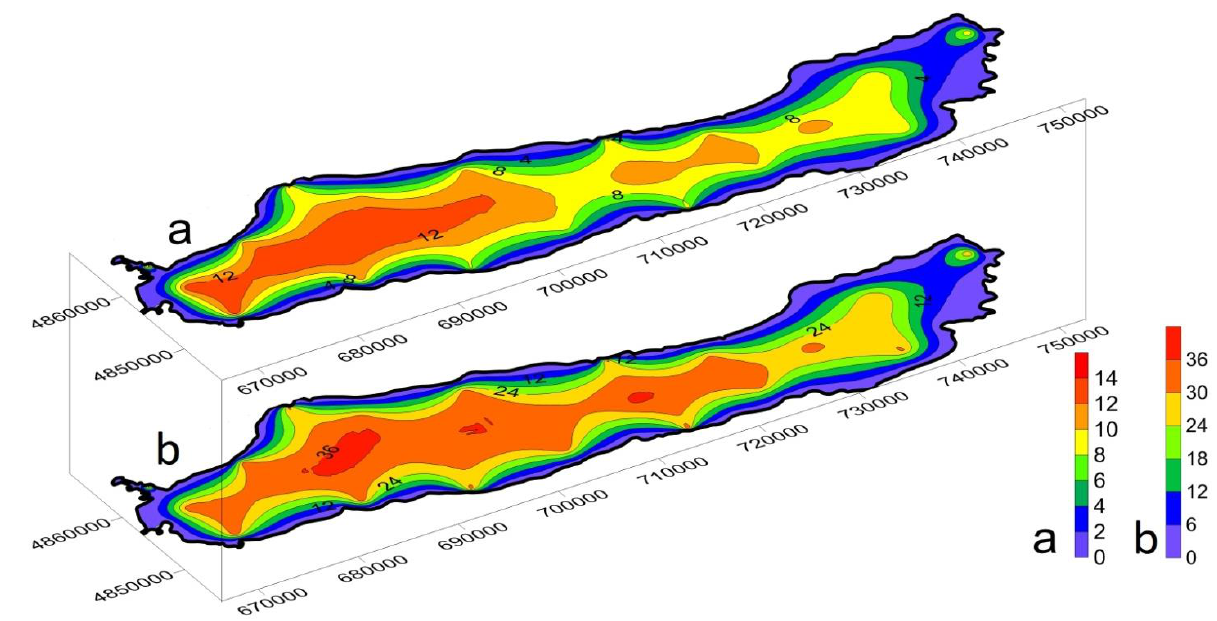
Figure 4. Spatial distribution of zinc in water and bottom sediment of the Kapshagay Reservoir. ( a ) Water — µg/L; ( b ) bottom sediment — mg/kg. (authors Ismukhanova L.T., Madibekov A.S.)